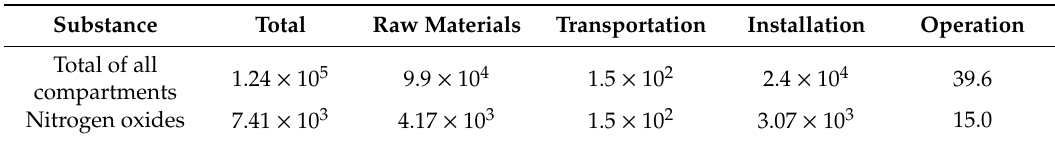
Table 11. Analyzing ‘TWF-Phases’; Method: TRACI / Characterization / Acidification Category / Nitrogen Oxides (NOx), Unit kg (H + moles eq ).